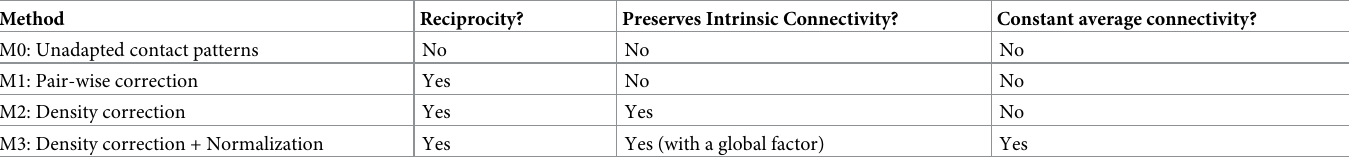
Table 1. Properties of different methods. Method